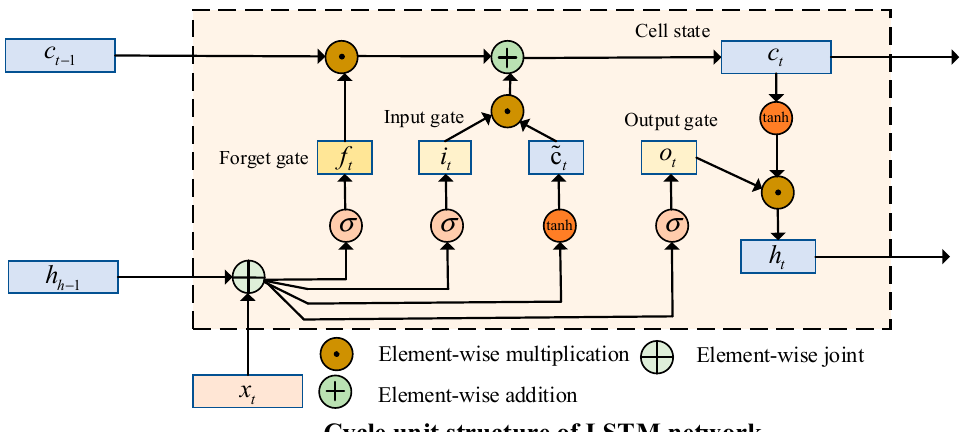
Figure 2. Internal memory block of an LSTM.